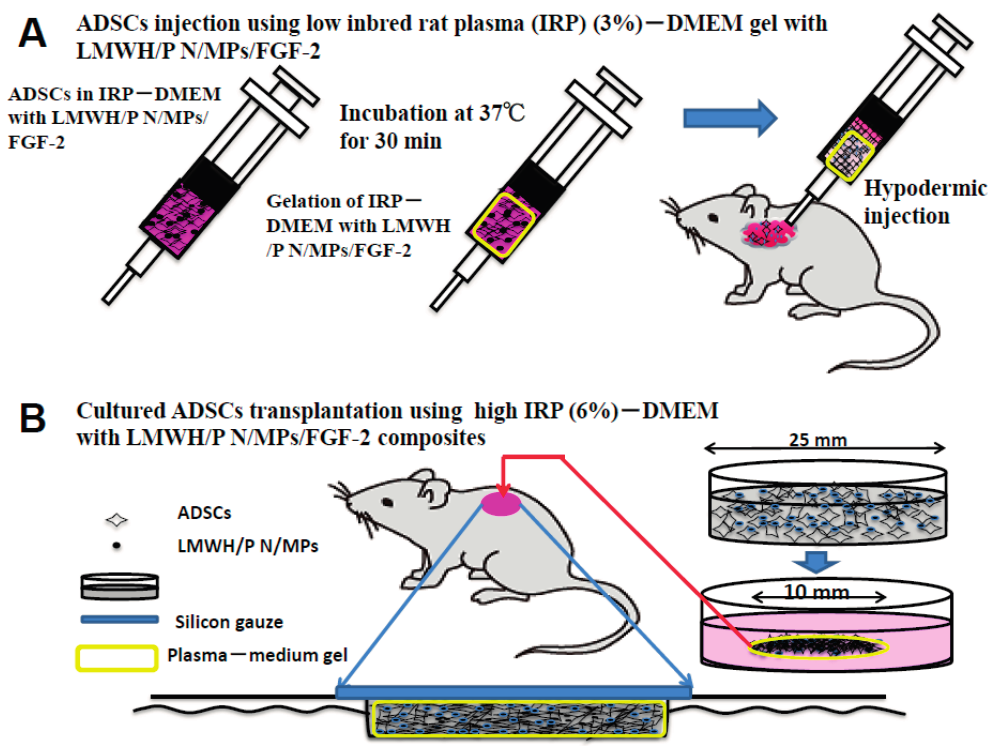
Figure 8. Two methods ( A , B ) for ADSCs transplantations using IRP-DMEM gel with LMWH/P